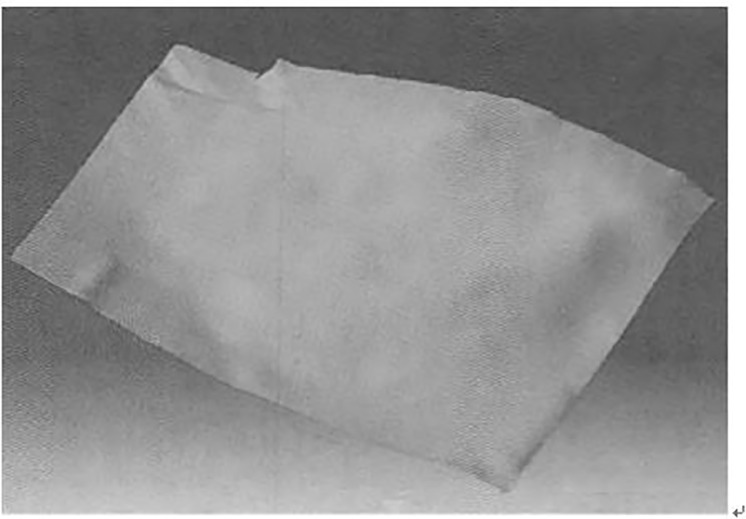
Ground surface model.